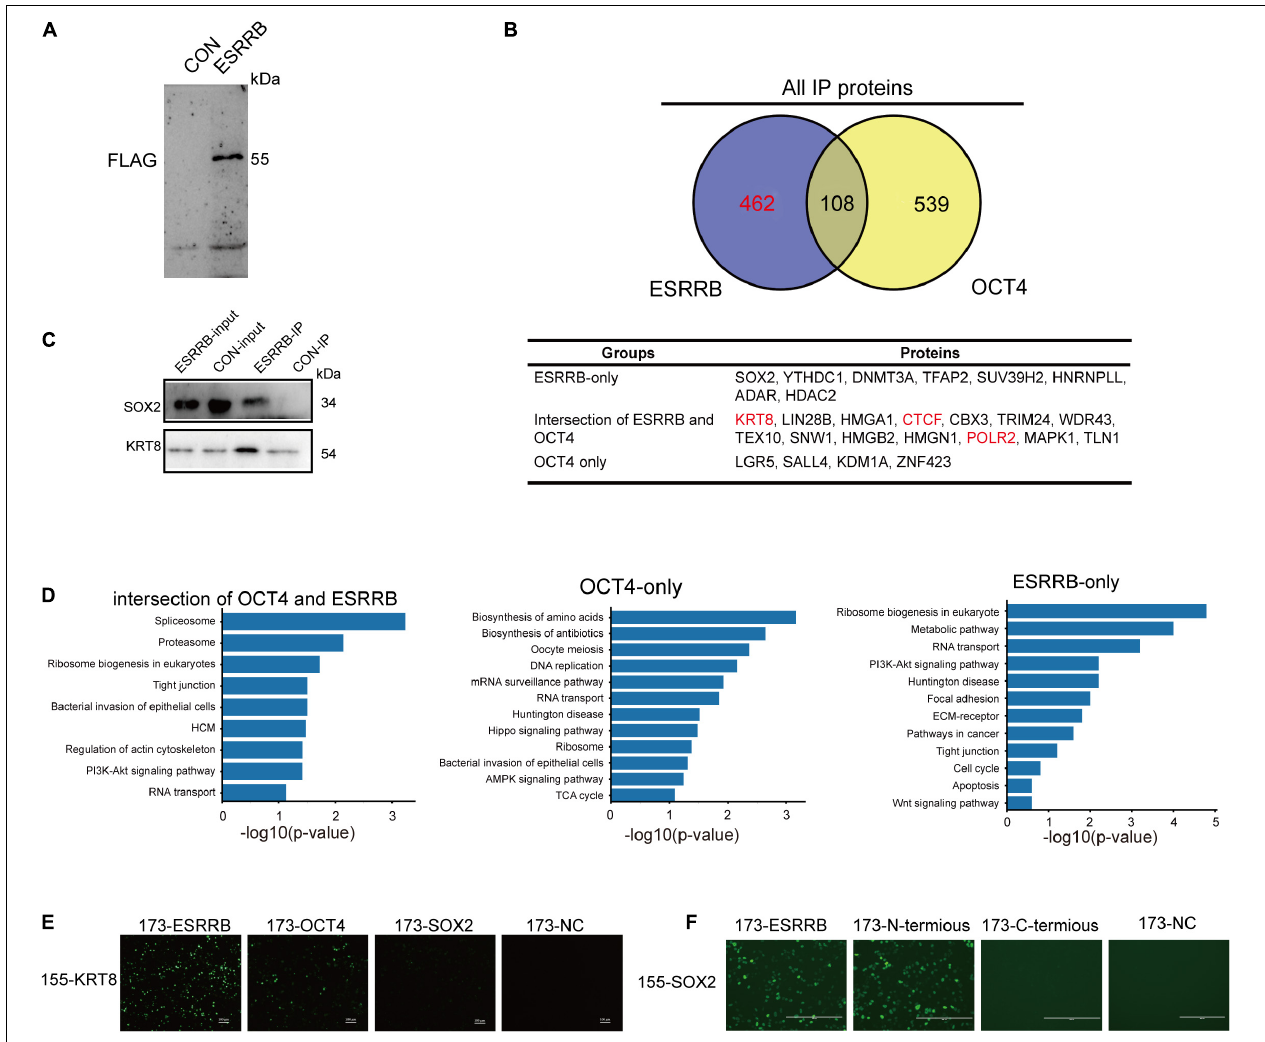
FIGURE 6 | Cooperative binding of core OCT4 and ESRRB to regulate CDX2. (A) Immunoprecipitation of ESRRB was validated using Western blot analysis. The piPSCs overexpressing 3FLAG-ESRRB were used to purify ESRRB-associated proteins. (B) Venn diagrams showing the overlap of OCT4- and ESRRB-associated proteins determined by mass spectrometry. The table lists some representative proteins of each section. (C) The correlation between ESRRB and OCT4 were validated by Western blot analysis. (D) The KEGG enrichment of ESRRB or OCT4-associated protein. (E) Representative image of bimolecular fluorescence complementation of ESRRB, SOX2, OCT4, and KRT8. The scale bar represents 200 µ m. (F) Representative image of bimolecular fluorescence complementation of ESRRB, its domain vectors, and SOX2. The scale bar represents 200 µ